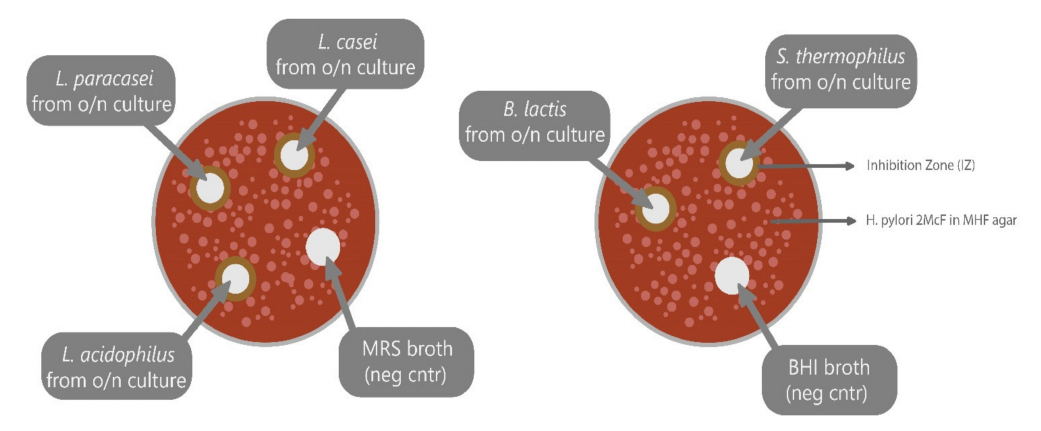
Figure 5. Agar well di ff usion seeding scheme. o / n: overnight. McF: McFarland. MHF: Mueller-Hinton-Fastidious agar.